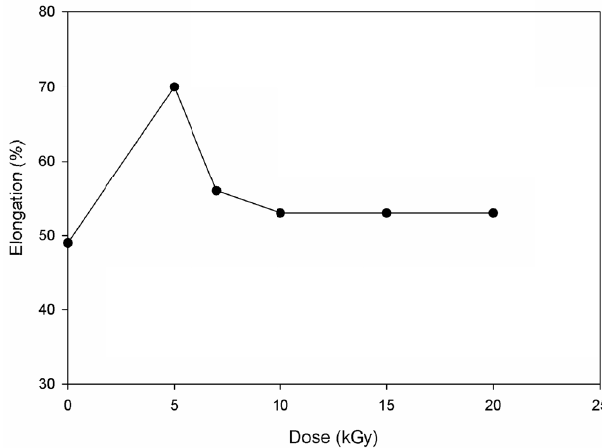
Fig. 3. Effect of different irradiation dose on the elongation (%) at break of untreated silk fabric and AgNPs-treated silk fabrics with different gamma irradiation